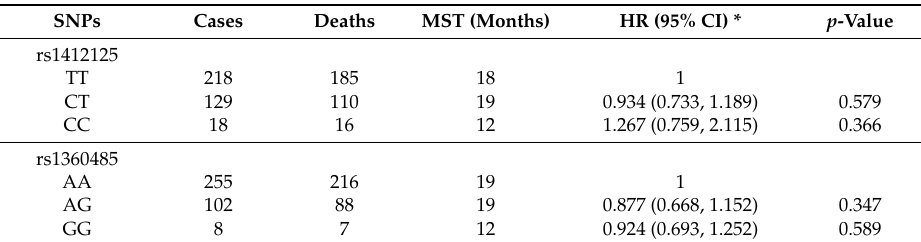
Table 8. The association between SNPs and survival of lung